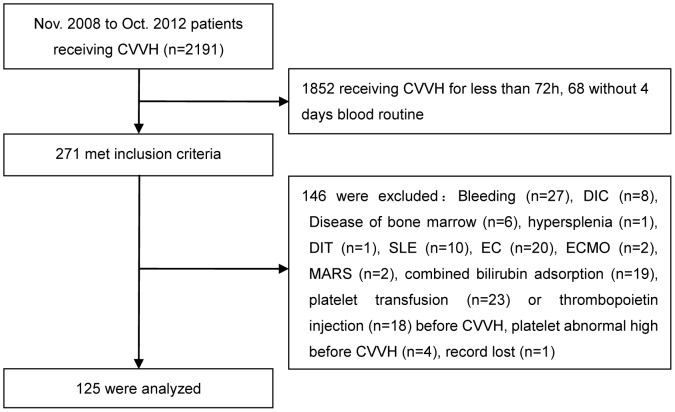
Flow chart of study participation.DIC: disseminated intravascular coagulation; DIT: drug-induced thrombocytopenia; SLE: systemic lupus erythematosus; EC: extracorporeal circulation; ECMO: extracorporeal membrane oxygenation; MARS: molecular adsorbent recirculating system.